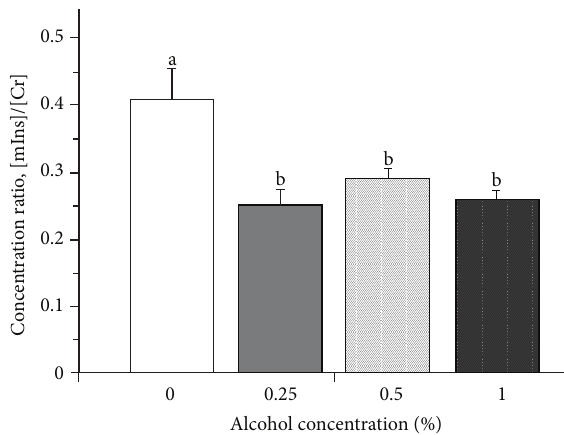
Figure 4: Acute, 1h long, alcohol exposure increases myo-inositol to the total creatine ratio ([mIns]/[tCr]): mean ± SEM (𝑛 = 10) . Bars not sharing a letter designation are significantly different from each other (𝑃 < 0.05) . Observe the apparent decrease in [mIns]/[tCr] at all acute doses and that all experimental groups significantly differ from the control.